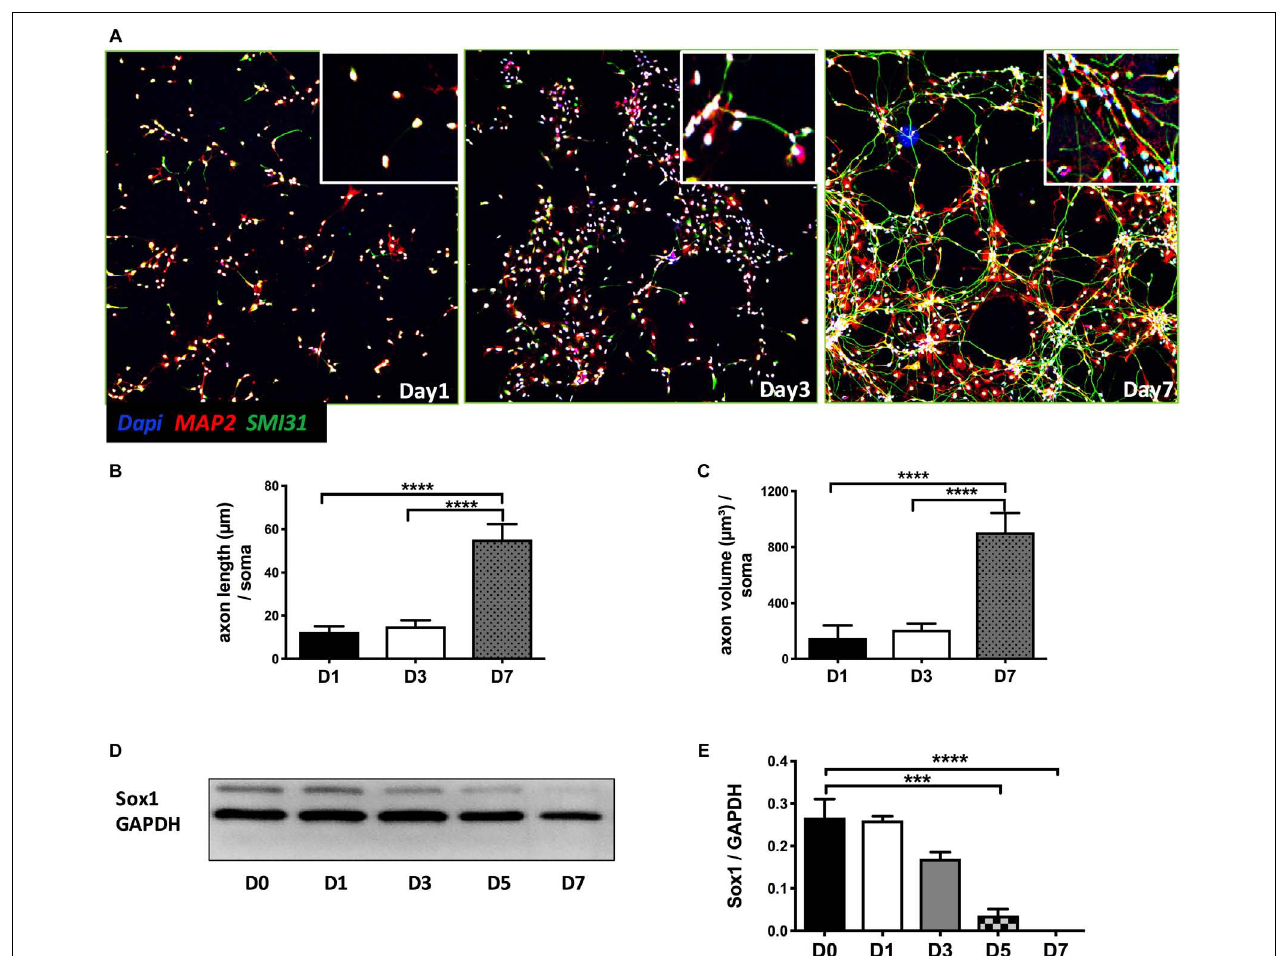
FIGURE 1 | Early stage of differentiation process of NPCs. (A) Seven days after bFGF removal, NPCs were fixed and stained for the dendritic and axonal markers MAP2 (green) and SMI 31 (red), respectively. Quantitation of axonal length (B) and volume (C) . (D) NPC lysates at days 0 to 7 differentiation were probed for the stem cell marker SOX1. Quantitation of SOX1 protein expression (E) . Data are expressed as mean ± S.E ( n = 3, ∗∗∗ p < 0.001, ∗∗∗∗ p < 0.0001, One-way